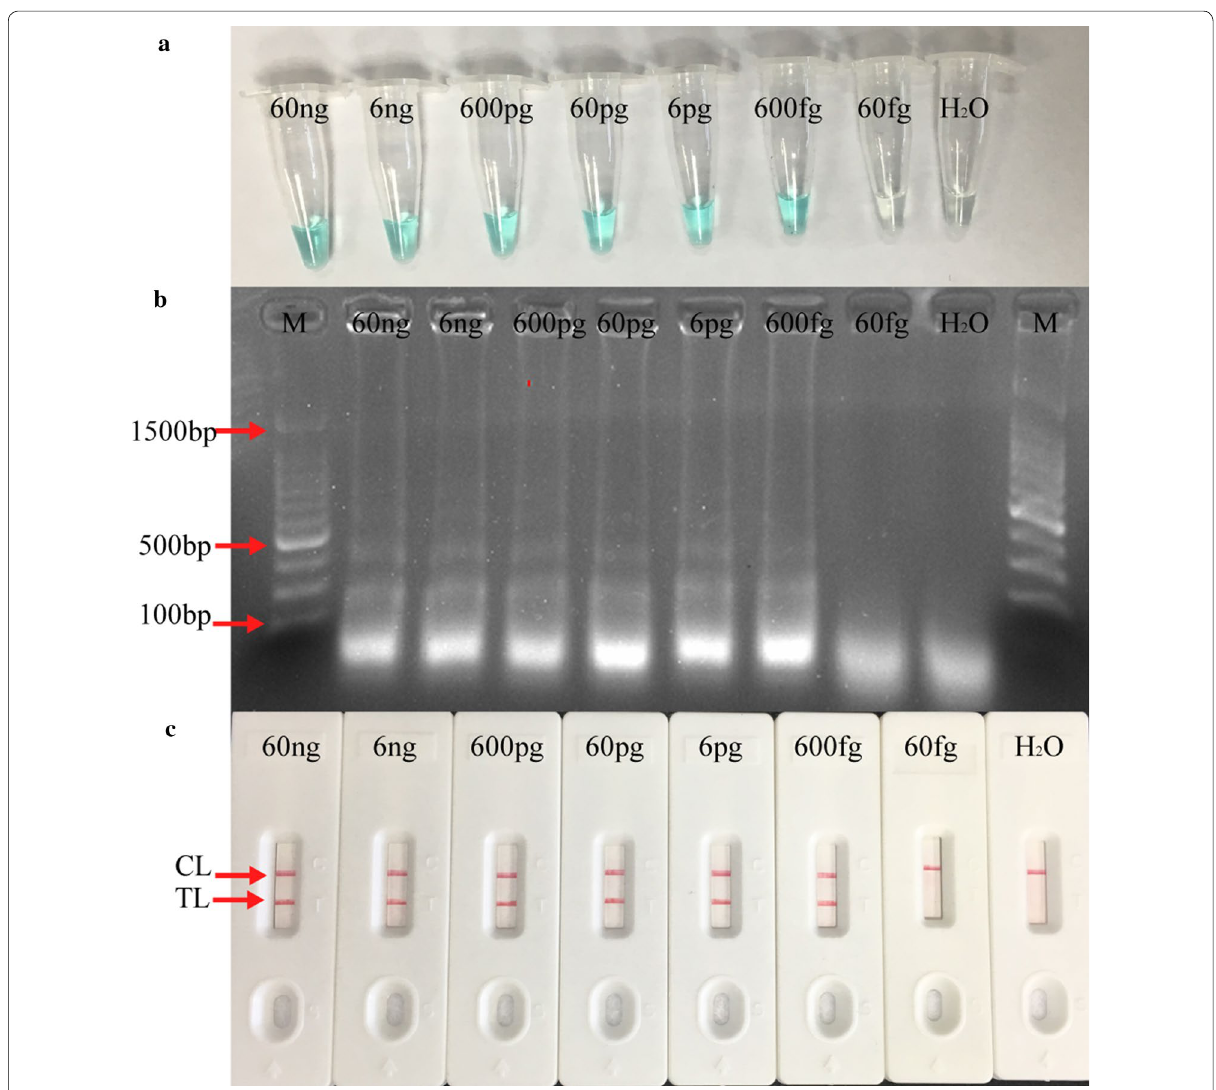
Fig. 4 Analytical sensitivity of MP-LAMP assay. Three monitoring methods: a colorimetric indicator; b agarose gel electrophoresis; c LFB were used for amplification products analysis. Serial dilutions (60 ng, 6 ng, 600 pg, 60 pg, 6 pg, 600 fg, 60 fg, 6 fg) of genomic DNA of MP were used for sensitivity determination of LAMP assay. The DNA templates of MP from 60 ng to 600 fg produced positive